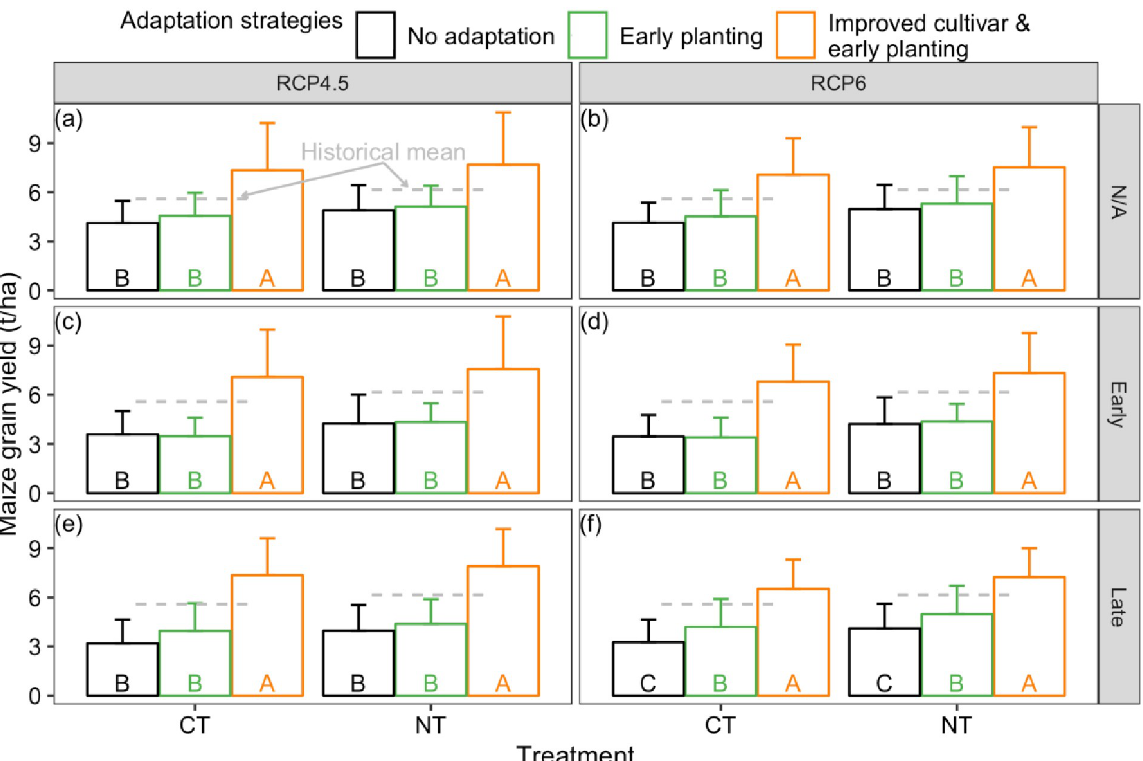
Fig 8. Average and standard deviation of the simulated maize yield with and without climate adaptation strategies under conventional tillage (CT) and no-till (NT) in the 24 years for various projected climate scenarios: (a-b) RCP4.5 and RCP6 climate without changing precipitation frequency, (c-d) RCP4.5 and RCP6 climate combined with changing precipitation frequency at maize and wheat early growth stage, (e-f) RCP4.5 and RCP6 climate combined with changing precipitation frequency at maize and wheat late growth stage (error bars represent the standard deviation; adaptation strategies sharing the same letter are not significantly different at P = 0.05 using Tukey’s honestly significant difference test within the tillage treatment).